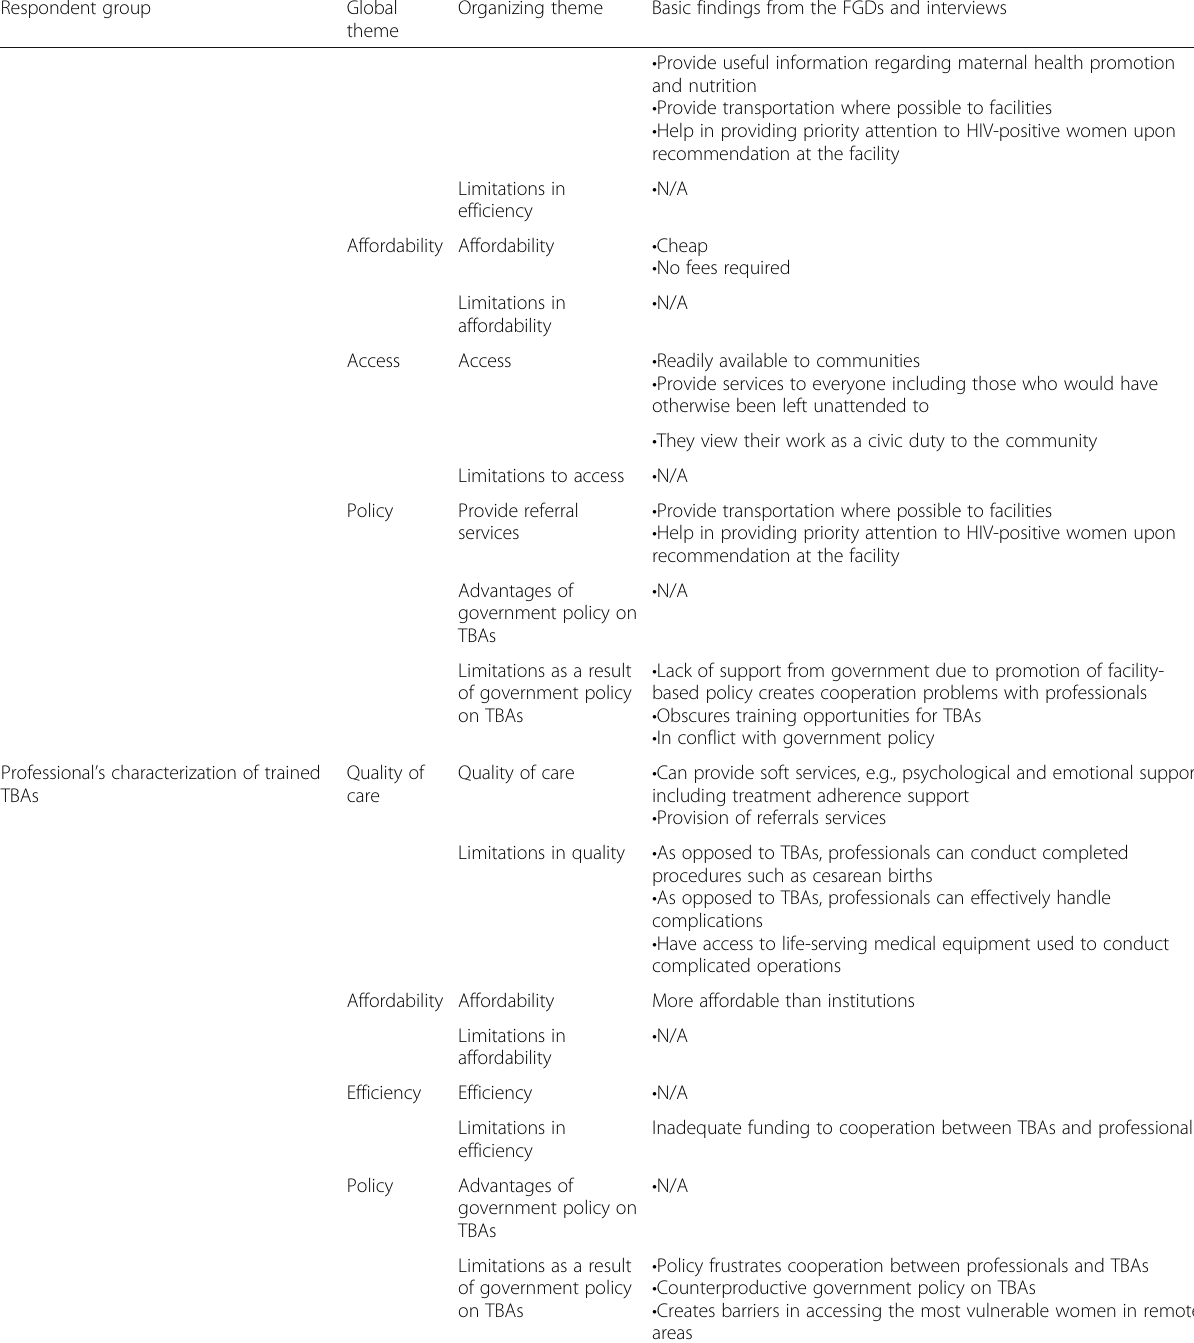
Table 2 Summary of qualitative results (Continued) Respondent